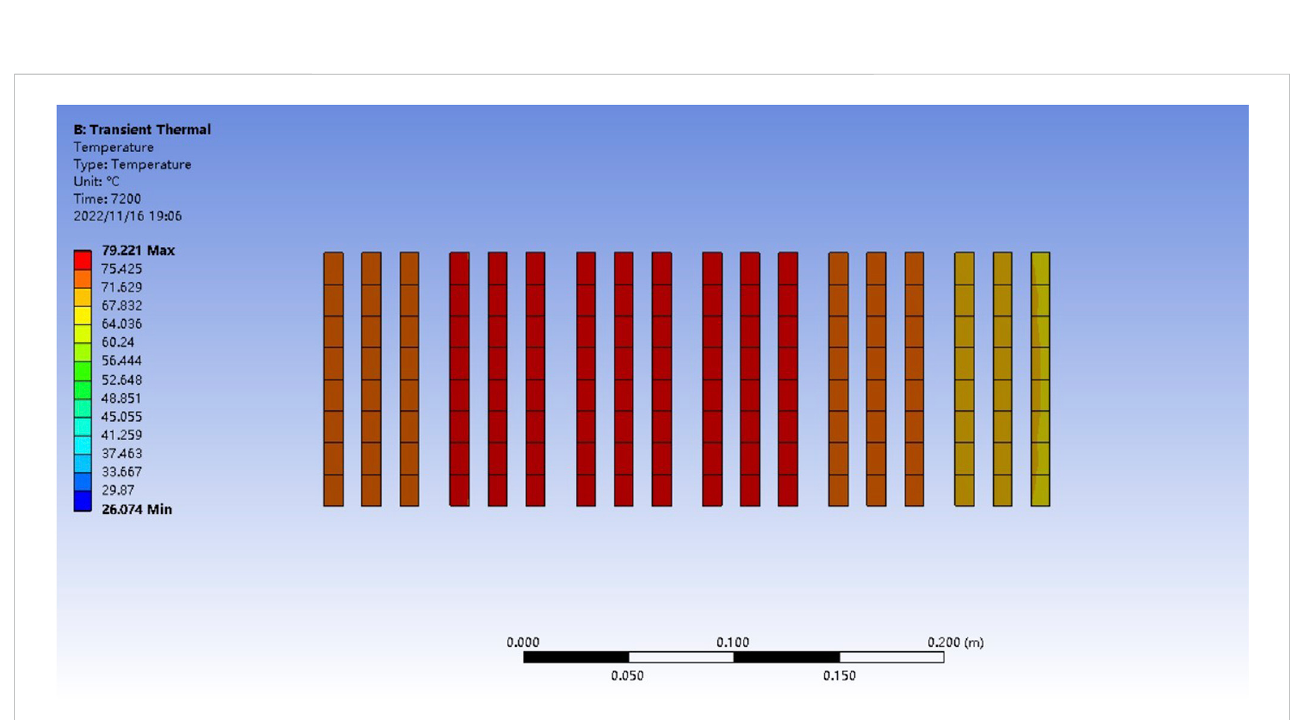
FIGURE 14 The temperature of the permanent magnet on the horizontal